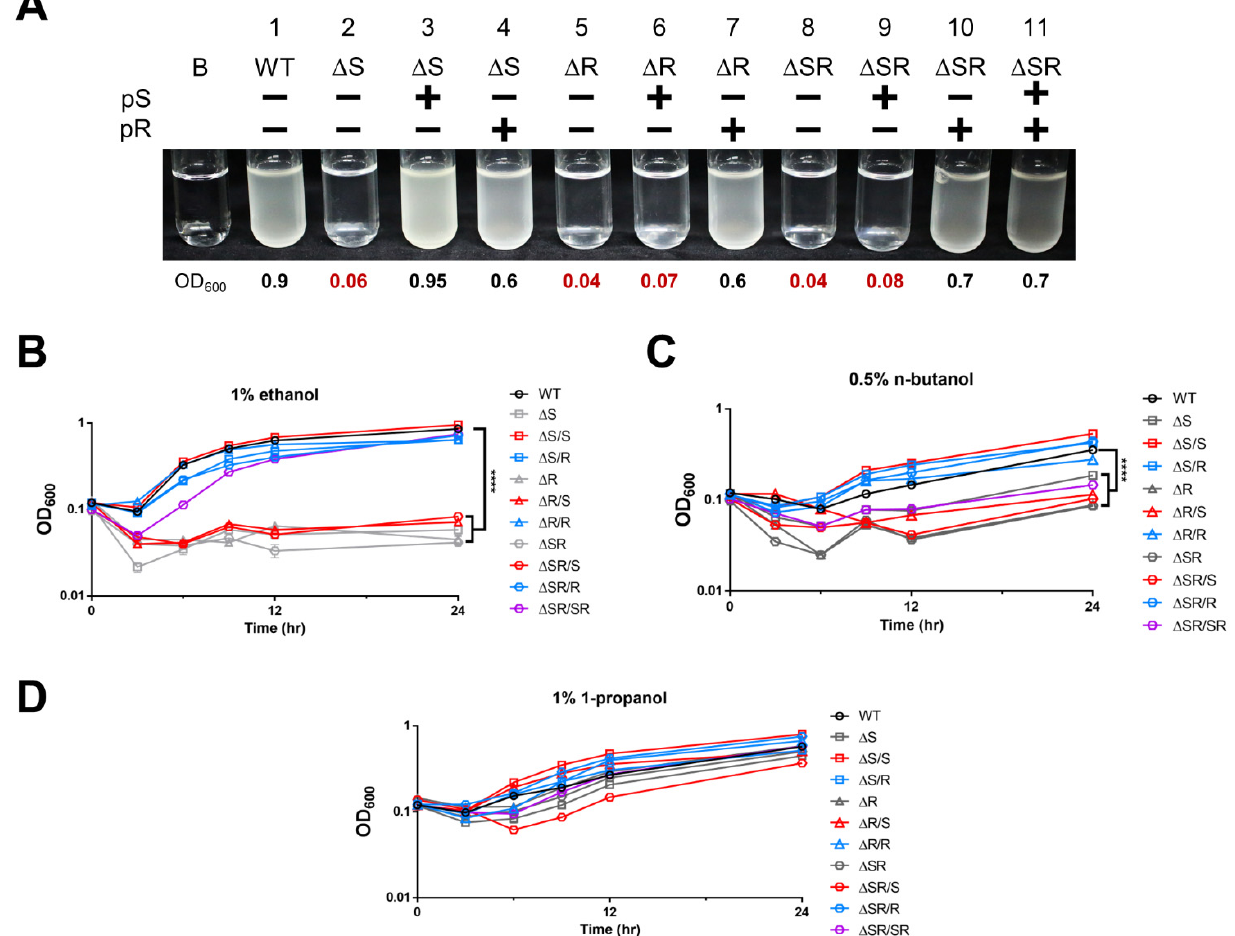
Figure 2. Growth conditions of mutant and complementary strains in M9 medium containing alcohols. ( A ) Strains cultured in test tubes for 24 hours. B stands for “blank,” and contains M9 medium only. WT represents wild-type. Numbers under the test tubes represent OD at 24 hours. Growth curves of strains cultured in M9 medium with ( B ) 1% ethanol (B), ( C ) 0.5% n-butanol, and ( D ) 1% 1-propanol are shown. Gray lines represent single- or double-mutants, while red lines indicate mutants complemented with pS, blue lines indicate mutants complemented with pR, and purple lines indicate double-mutants complemented with pSR. Representative results from three independent experiments are shown. **** p < 0.0001 (WT vs. Δ S, Δ R, Δ R/S, Δ SR, Δ SR/S).